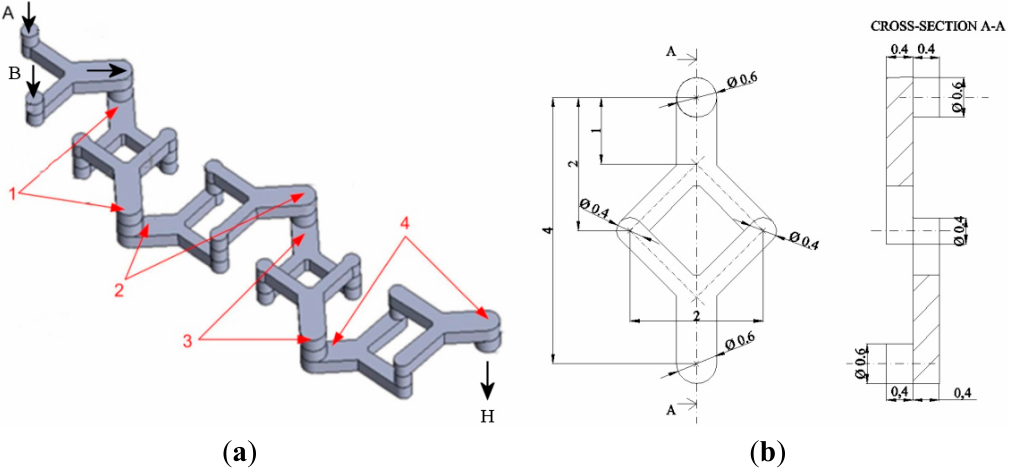
Figure 2. Geometry of the Y-Y micromixer (dimensions in mm): ( a ) three-dimensional view; ( b ) top view of one element and cross-section.